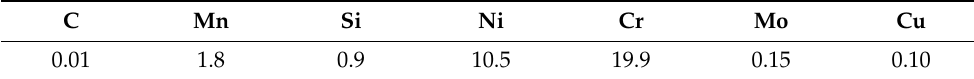
Table 1. Chemical composition of the steel studied